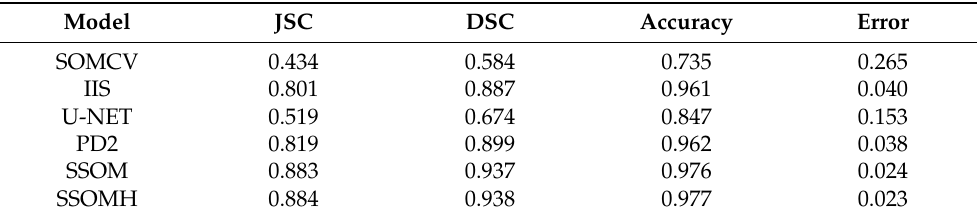
Table 1. Average Values of JSC, DSC, Accuracy and Error for All Models.